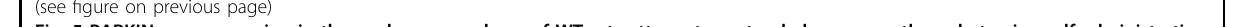
Fig. 5 PARKIN overexpression in the nucleus accumbens of WT rats attenuates extended-access methamphetamine self-administration (EA METH SA) and METH reward. Escalation of METH taking in rats overexpressing PARKIN in the nucleus accumbens as compared to non- expressing wild-type (WT) rats during an increasing ratio schedule of reinforcement: FR1, FR2, and FR5. A At the low PARKIN overexpression (4 – 6- fold), the PARKIN overexpressing (PO) rats did not press for METH at a signi fi cantly lower rate than the WT rats and, consequently, B they did not consume less METH than the WT rats. C At the high PARKIN overexpression (15 – 20-fold), the PO rats did press for METH at a signi fi cantly lower rate than the WT rats and D consumed less METH than the WT rats. * p < 0.05, ** p < 0.01, *** p < 0.001, WT vs. PO-H, n = 6/group. E Quanti fi cation of total METH intake in PO-L and PO-H rats as compared to their respective WT control groups. There was no signi fi cant difference in total METH intake between the PO-L group and WT controls whereas the PO-H group consumed signi fi cantly less METH than the WT group ( − 33%, *** p < 0.001). F Correlation analysis of total METH intake with PARKIN levels in PO-H group (red dots: PO-H group; green dots: WT group). G The 15 – 20-fold excess of PARKIN was suf fi cient to signi fi cantly attenuate preference for METH (4 mg/kg) in WT rats in the conditioned place preference test. *** p < 0.001 as compared to the respective saline controls, # p < 0.05 WT vs. PO-H, n = 6/group. Data are expressed as mean ± SEM. Abbreviations: NAc nucleus